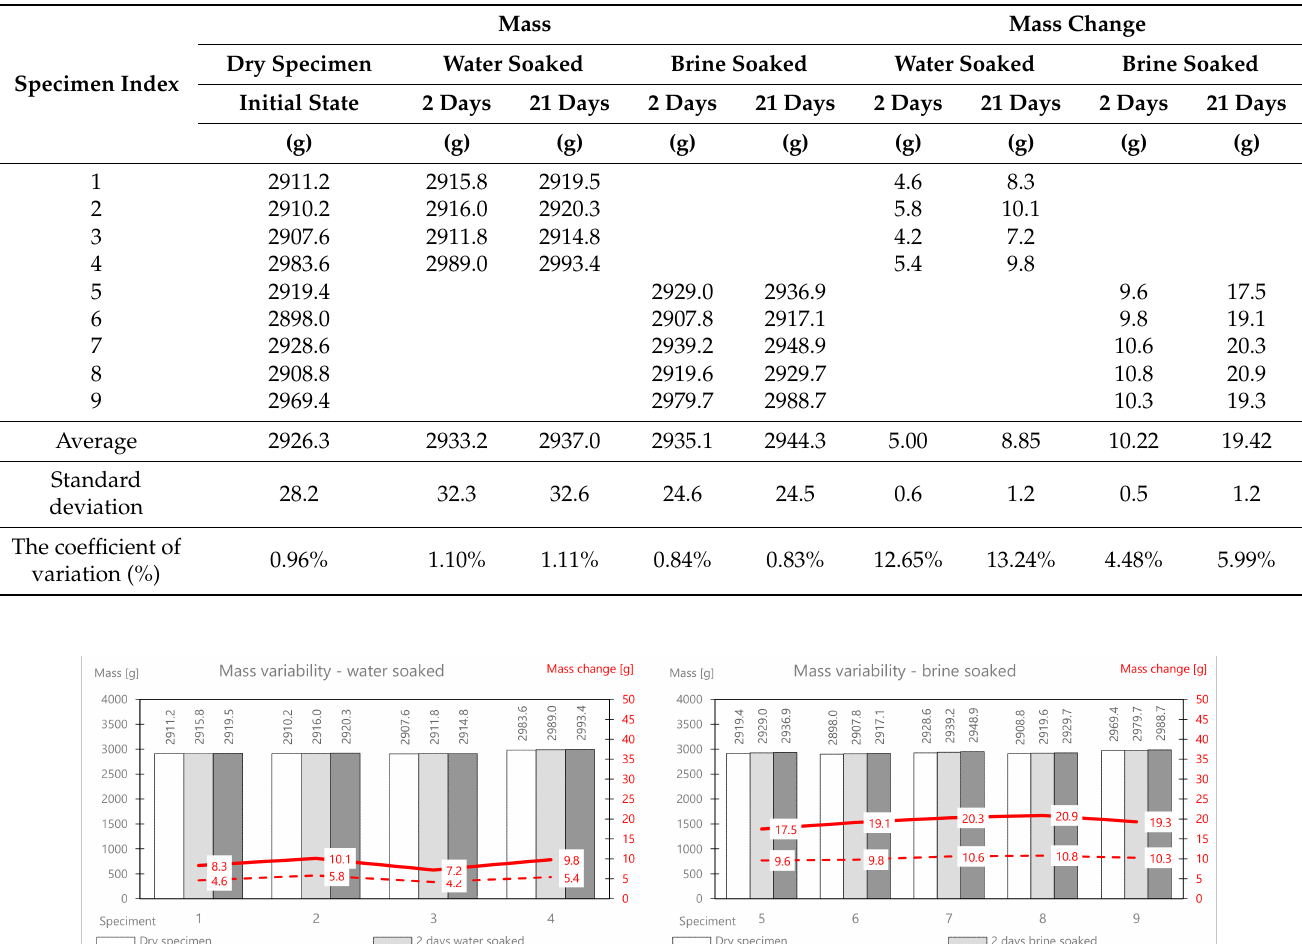
Table 5. Mass variability of AC 22 WMS(Pmb) via soaking in water and brine.